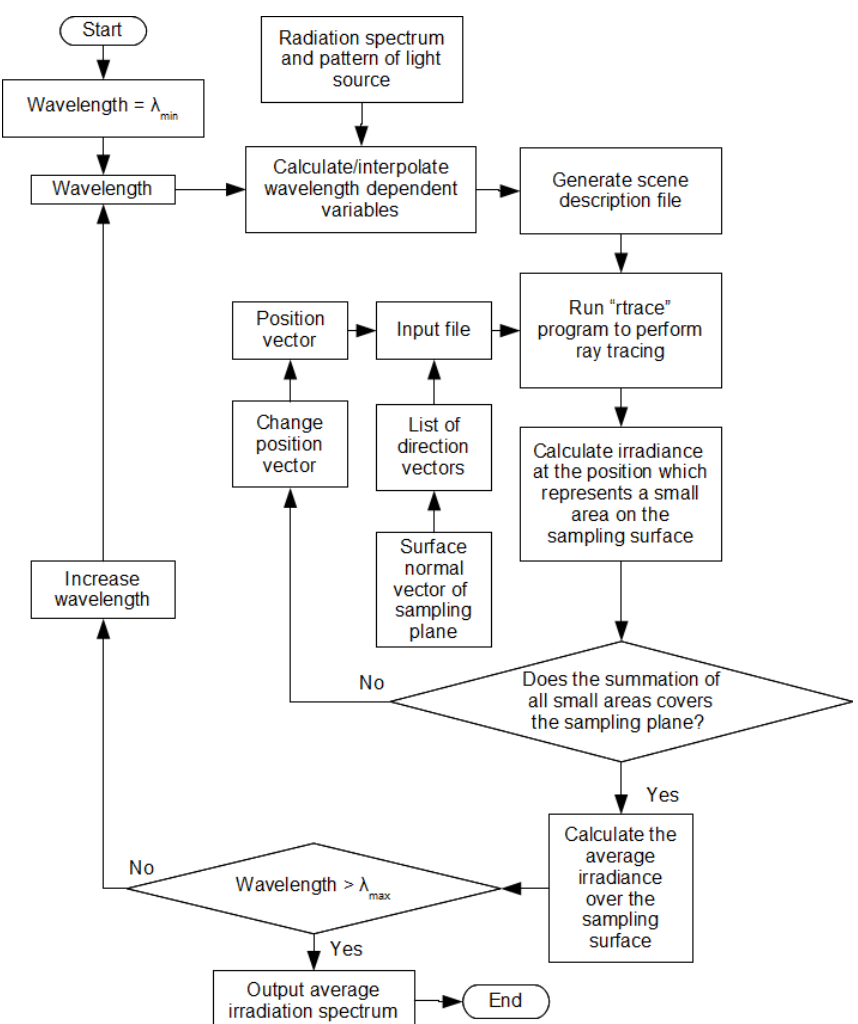
Figure 5. Flow chart of the ray-tracing